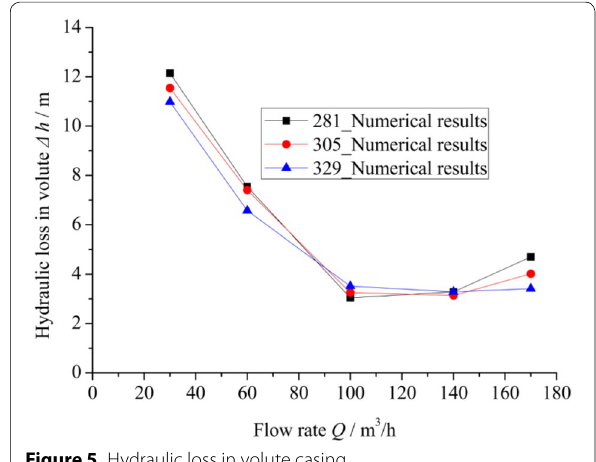
Figure 5 Hydraulic loss in volute casing